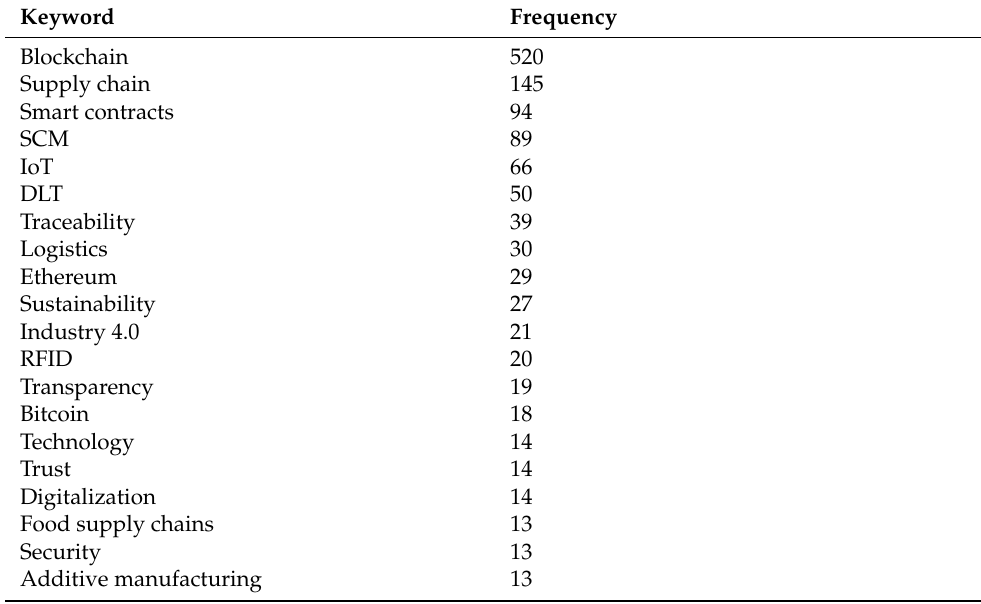
Table 6. Top 20 most frequently occurring keywords.